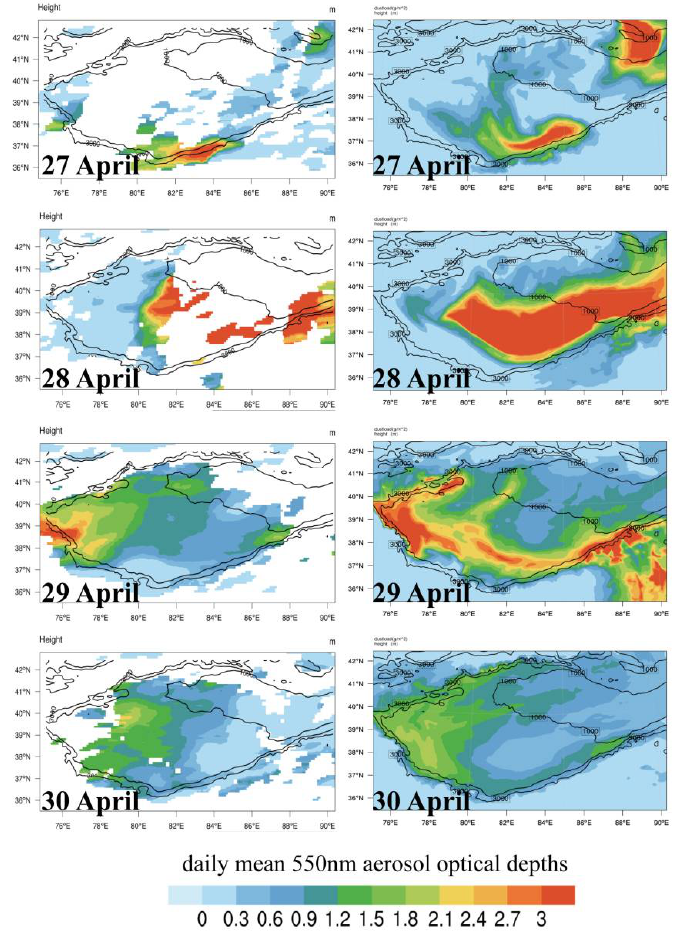
Figure 4. Spatial distributions of the daily average 550 nm AODs retrieved from MODIS ( left column) with the corresponding simulations by WRF-Chem ( right column) within the TB throughout the selected dust storm.